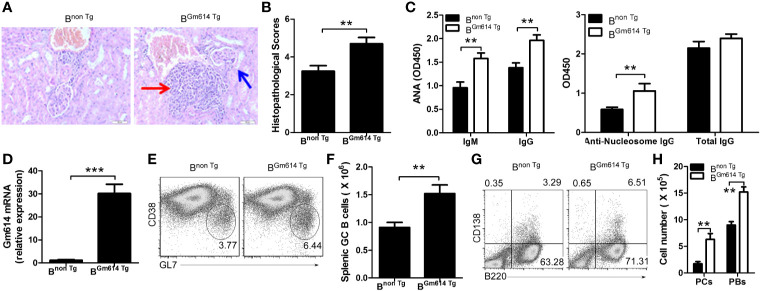
Gm614 transgene (Tg) in B cells (BGm614 Tg) exacerbated symptoms in pristane-induced lupus. Nine-week-old Bnon Tg and BGm614 Tg mice were i.p. injected with 0.5 ml pristane and analyzed 6 months after injection. (A) Gm614 Tg promoted inflammatory cells to infiltrate into the kidney in pristane-induced lupus. H&E-stained sections of the kidney. Scale bars, 50 µM. Blue arrows show glomeruli; red arrows show infiltrated inflammatory cells that appeared in the surrounding interstitial vasculature. (B) Gm614 Tg up-regulated histopathological scores of kidney. Histopathological scores were assessed based on loss of brush border, grading of tubular necrosis, tubular dilatation, and cast formation in 10 randomly chosen, non-overlapping fields. (C) Gm614 Tg up-regulated autoantibodies in pristane-induced lupus. Anti-nucleic antibodies (ANA) IgM and IgG, anti-nucleosome IgG, and total IgG were determined in the sera using ELISA assay. (D) Gm614 was overexpression in BGm614 Tg mice. Splenic CD19+B220+CD38loGL7hi GC B cells were sorted by FACS and subject to qPCR. (E, F) Gm614 Tg up-regulated GC B cells in pristane-induced lupus. On gated CD19+B220+ B cells, CD38loGL7hi GC B cells were analyzed by FACS. The percentages (E) and absolute numbers (F) of splenic GC B cells are shown. (G, H) Gm614 Tg up-regulated PBs and PCs in pristane-induced lupus. The percentages (G) and absolute numbers (H) of splenic CD138+B220+ PBs and CD138-B220+ PCs cells are shown. (A–H) Data represent three independent experiments, with six samples per group per experiment. (C, H) Two-Way ANOVA was followed by Bonferroni post-tests and (B, D, F) Student’s t-test (two tailed), Error bars, s.e.m., **p < 0.01, ***p < 0.001.